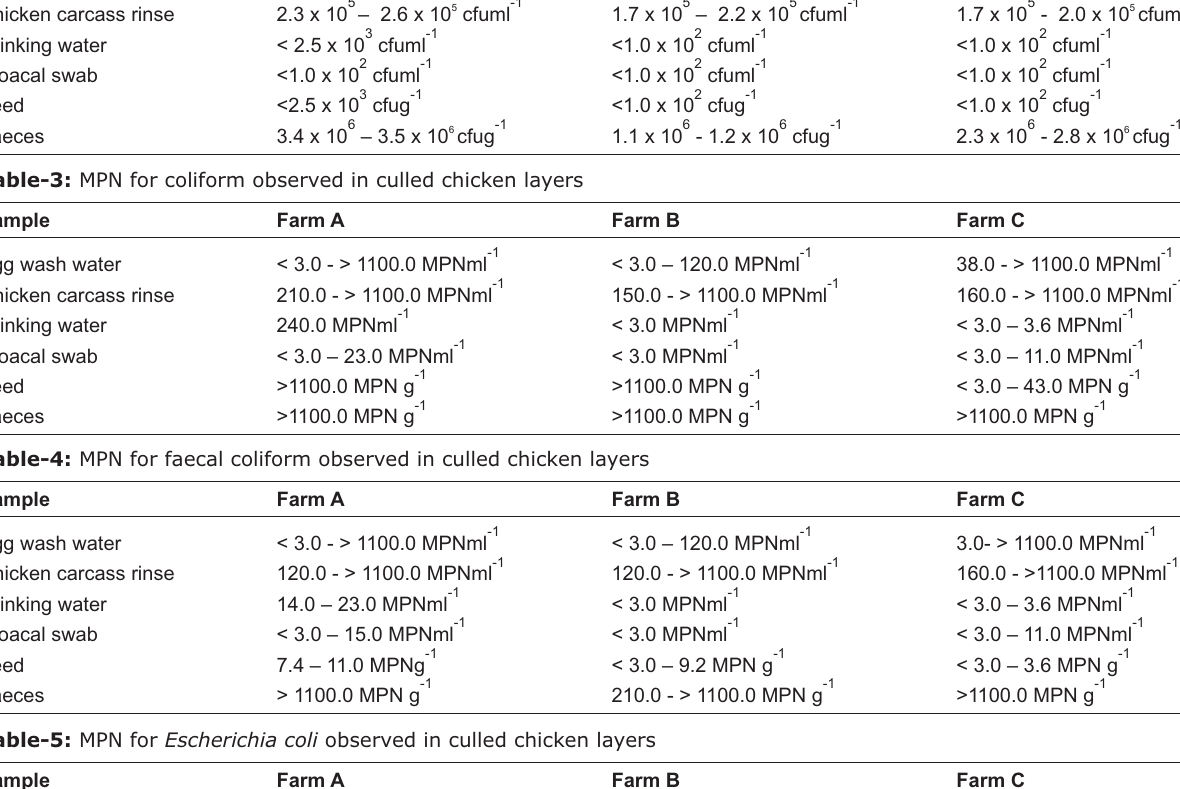
Table-2: count observed in culled chicken layers and their environmental samples Enterobacteriaceae Sample Farm A